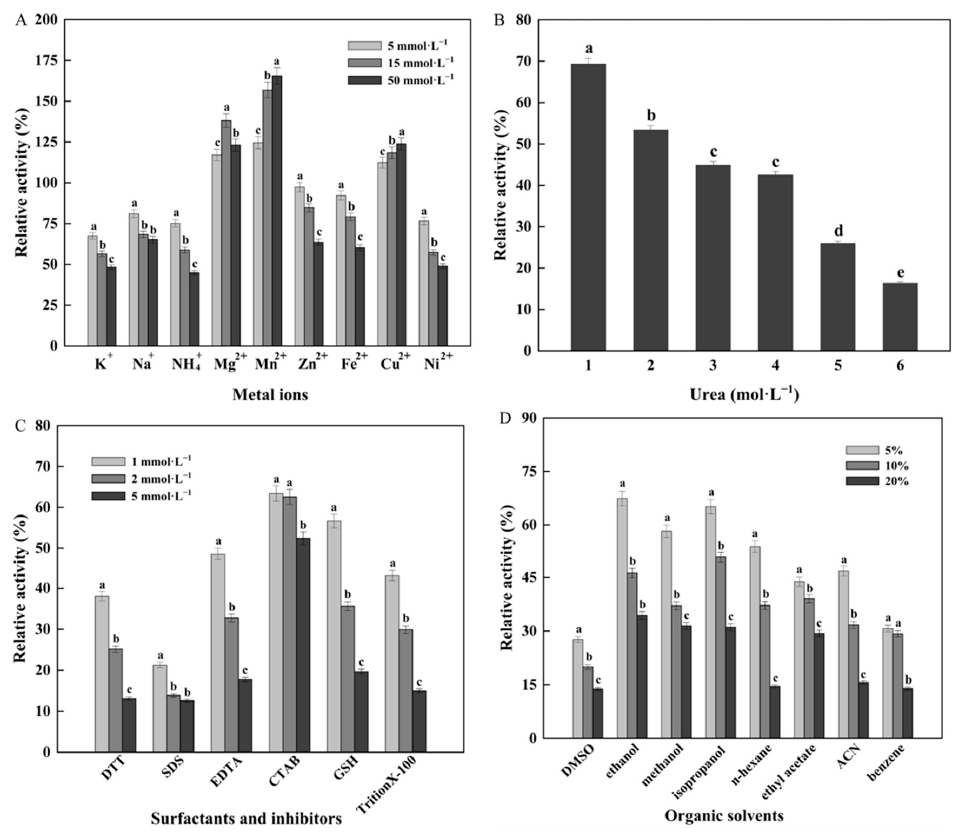
Figure 5. Effects of metal ions ( A ), urea concentration ( B ), surfactant and inhibitions ( C ) and organic solvents ( D ) on the enzyme activity of W. cibaria F1 mannanase. Different letters in superscript donate significant difference ( p < 0.05).